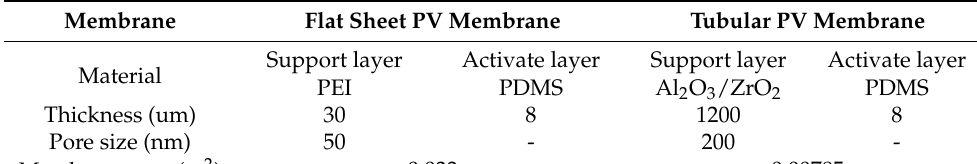
Table 1. Characteristics of the membranes used in this study.